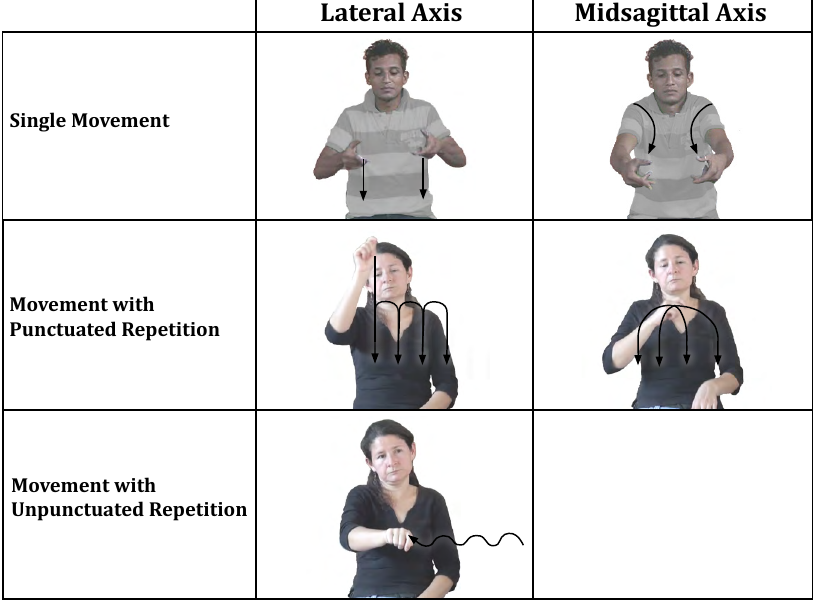
Fig. 3. Illustration of single and repeated (punctuated and unpunctuated) movements in the Lateral axis (Left column), and single and repeated (punctuated) movements in the Midsaggittal axis (Right column). Note that unpunctuated repetition does not occur in the midsagittal